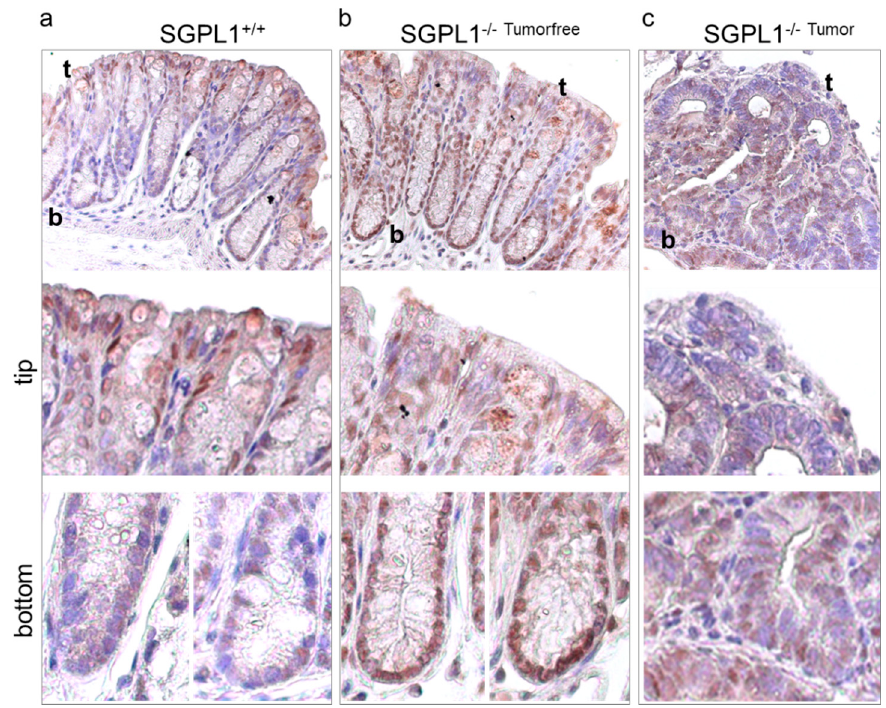
Figure 3. Anti-FOXO3 staining ( n = 5) of ( a ) wildtype (SGPL1 +/+ ) and ( b ) SGPL1 knockout (SGPL − / − ) colon sections and ( c ) SGPL1 knockout colon tumor sections after CAC induction (9 weeks); (mag- nification 40× in ‘overview’). CAC = colitis associated colon cancer; in image: t = Crypt tip; b = crypt bottom.